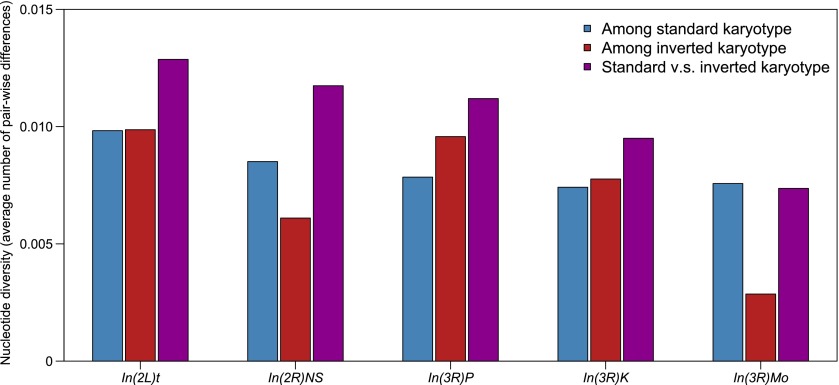
Nucleotide diversity (π) within standard karyotypes (blue bars), within inverted karyotypes (red bars), and between standard and inverted karyotypes (purple bars) within genomic regions encompassed by common polymorphic inversions. The calculation was based on nonmissing genotypes only, with indels (>1 bp) or multiple nucleotide polymorphisms receiving the same weight as SNPs regardless of their length.